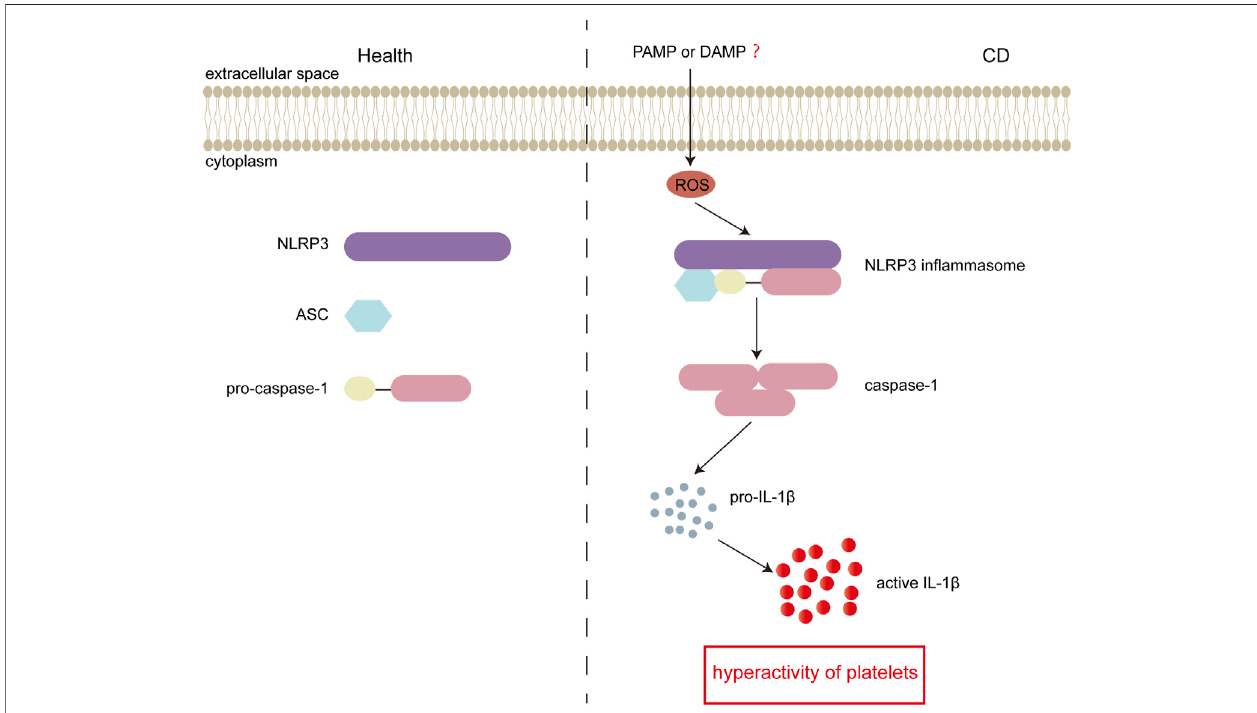
FIGURE 6 | Schematic representation of in fl ammasome activation in active Crohn ’ s disease (CD). In active CD, the bacteria derived DAMPs and pathogen- associated molecular patterns(PAMPs) could enter platelets and induce generationofintracellularROS. Elevated ROS consequently stimulates theassembly ofNLRP3 in fl ammasome. Followed by activation of NLRP3 in fl ammasome, pro-caspase-1 is cleaved into active caspase-1, and consequently induces generation of interleukin- 1 β , which results in platelet hyperactivity. In the healthy group, there is no formation of the NLRP3 in fl ammasome.